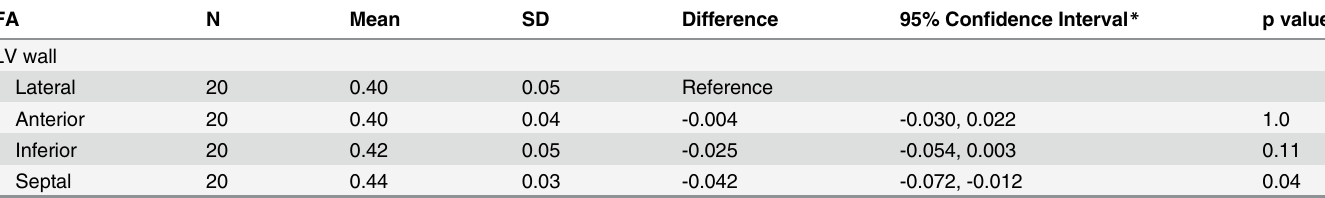
Table 1. Fractional Anisotropy Regional Analysis. Lateral wall used as the reference for statistical comparisons.